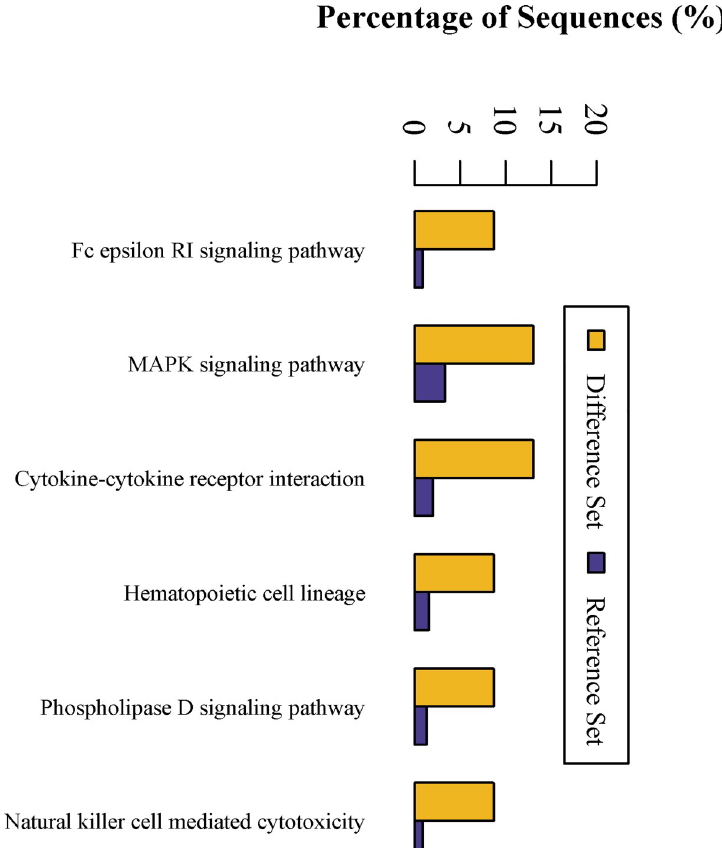
Fig 8. KEGG enrichment analysis of differential expression proteins. The x axis represents the pathway in which the different proteins participate, and the y axis represents the sequence percentage. The yellow bar represents the differential set and the blue bar represents the reference